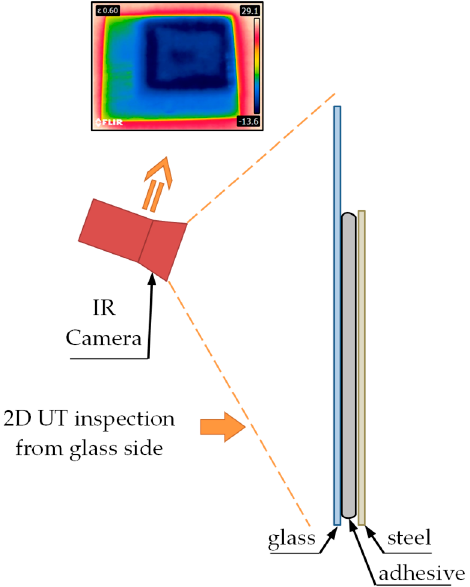
Figure 8. Scheme of the test stand used during the measurements of the sample with the IR camera.